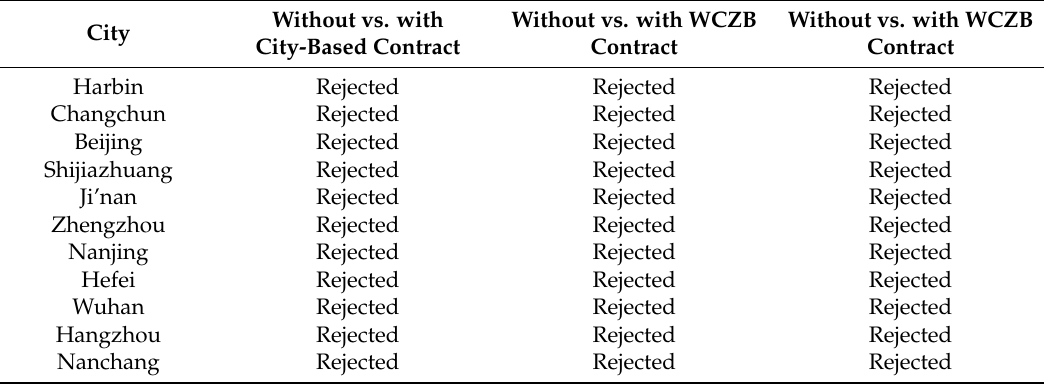
Rejected Rejected